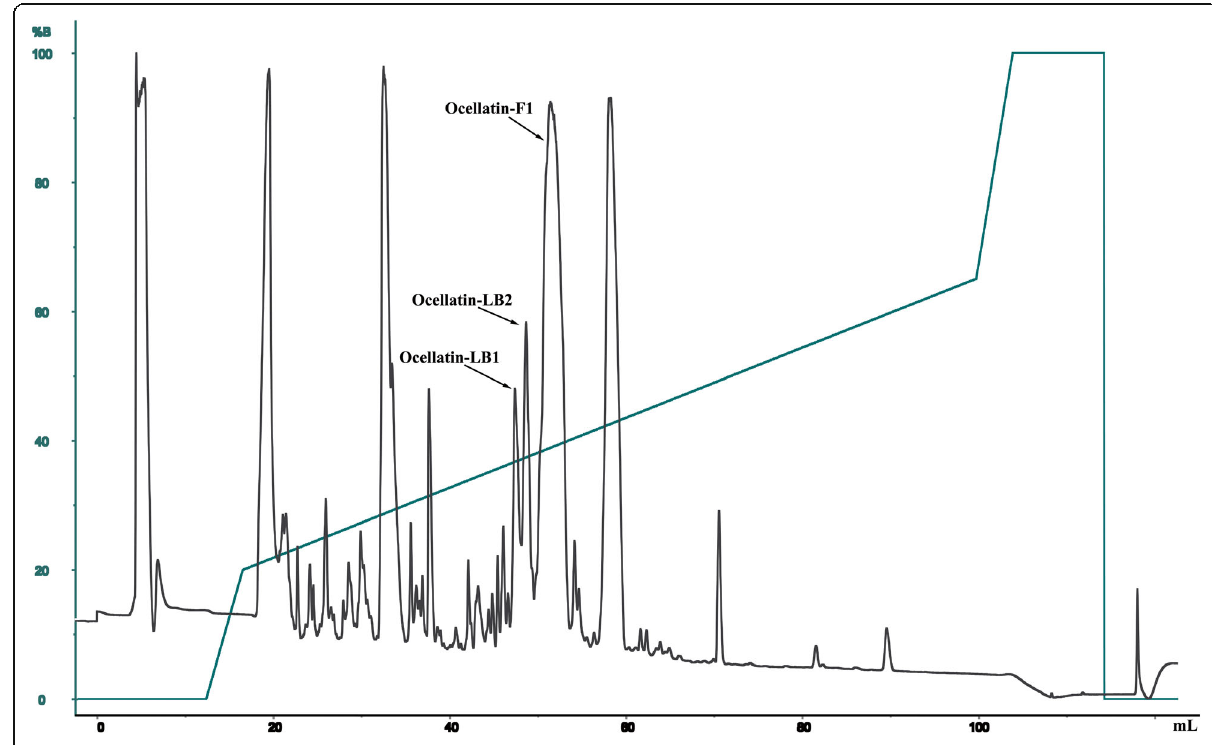
Fig. 1 RP-HPLC profile on a preparative C8 reversed-phase column (Discovery Supelco – 4.6 × 250 mm) of pooled skin secretion of L. labyrinthicus . Left axis: acetonitrile concentration along the gradient. The arrow indicates the fractions that were sequenced by automated Edman